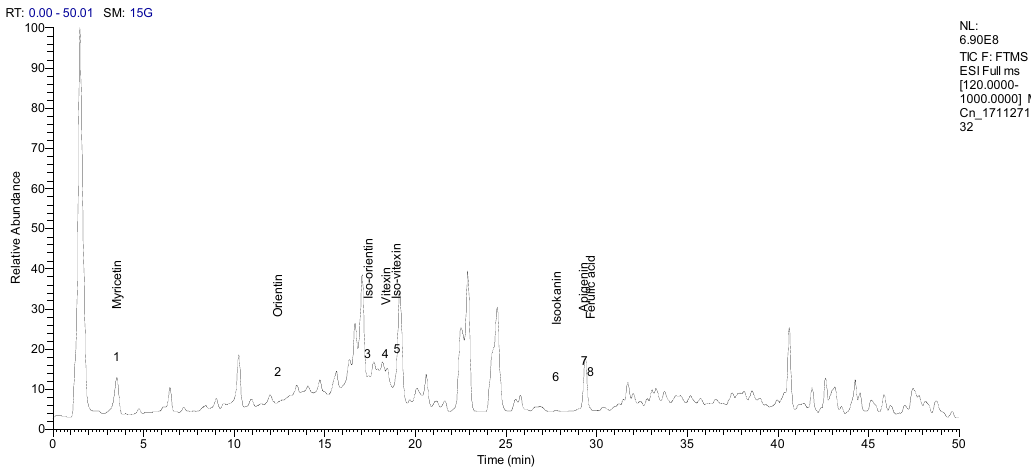
Figure 1. Total ion chromatograms (TIC) of the compounds in Clinacanthus nutans ethanolic leaf extract (CELE).